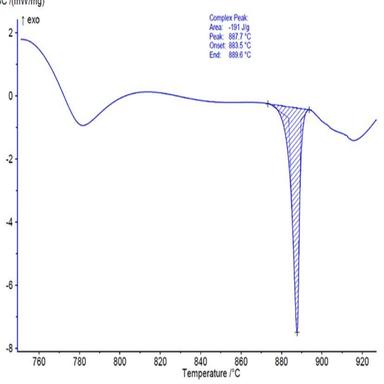
DSC results for H885 molten salt PCM freeze and melt temperature profile.